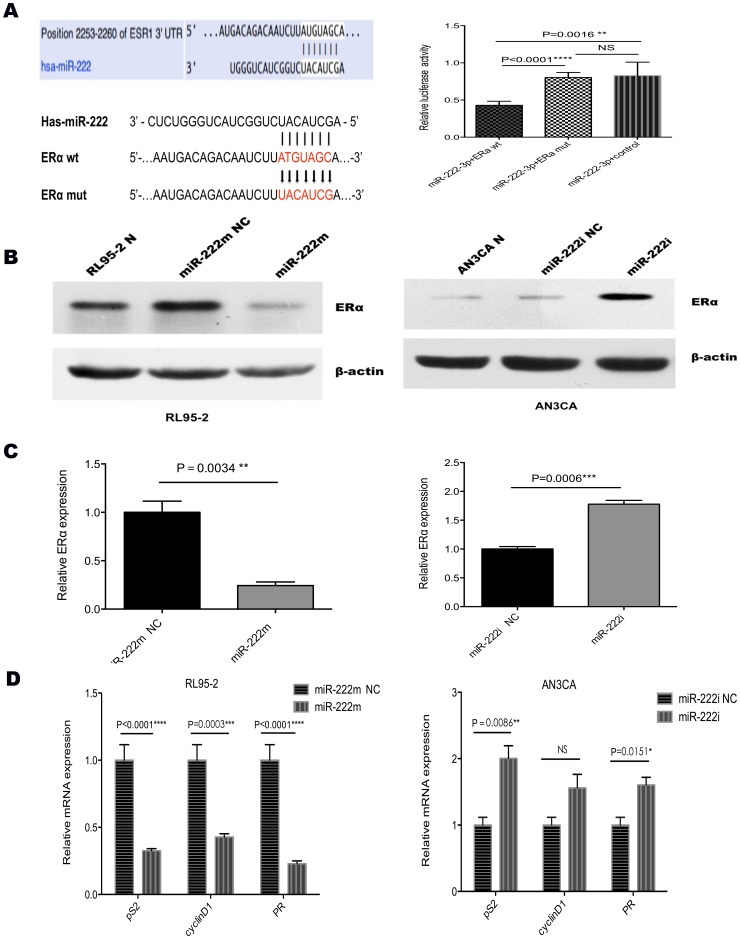
MiR-222-3p negatively regulates ERα.(A) ERα 3′ UTRs is a target of miR-222-3p. P3′UTR-ERα luciferase constructs, containing a wild type or mutated type ERα 3′ UTRs, were transfected into RL95-2 cells. Relative repression of firefly luciferase expression was standardized to a transfection control. The reporter assays were performed three times with essentially identical results. (B and C) MiR-222-3p and ERα levels were analyzed by qRT–PCR and western blot method, respectively. ERα levels decreased when miR-222-3p was upregulated in response to the miR-222m in RL95-2 cells, whereas the reverse was observed for ERα expression when miR-222-3p was knocked down in AN3CA cells. (D) The expression of pS2, cyclin D1 and PR was down regulated after miR-222m transfection in RL95-2 cell lines. Oppositely, in AN3CA cells, these ERα downstream genes were increased with miR-222-3p dampened. * P<0.05, ** P<0.01, *** P<0.001, **** P<0.0001.